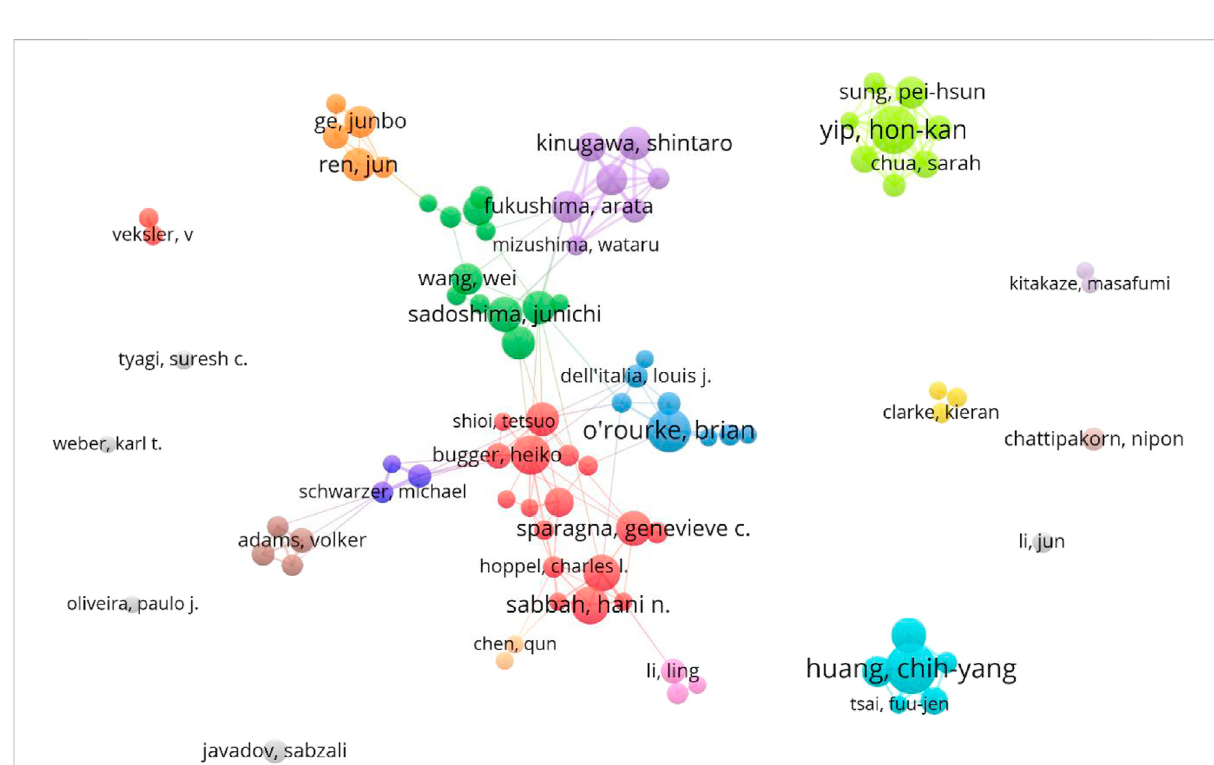
FIGURE 6 VOSviewer visualization map of authors involved in mitochondrial function and heart